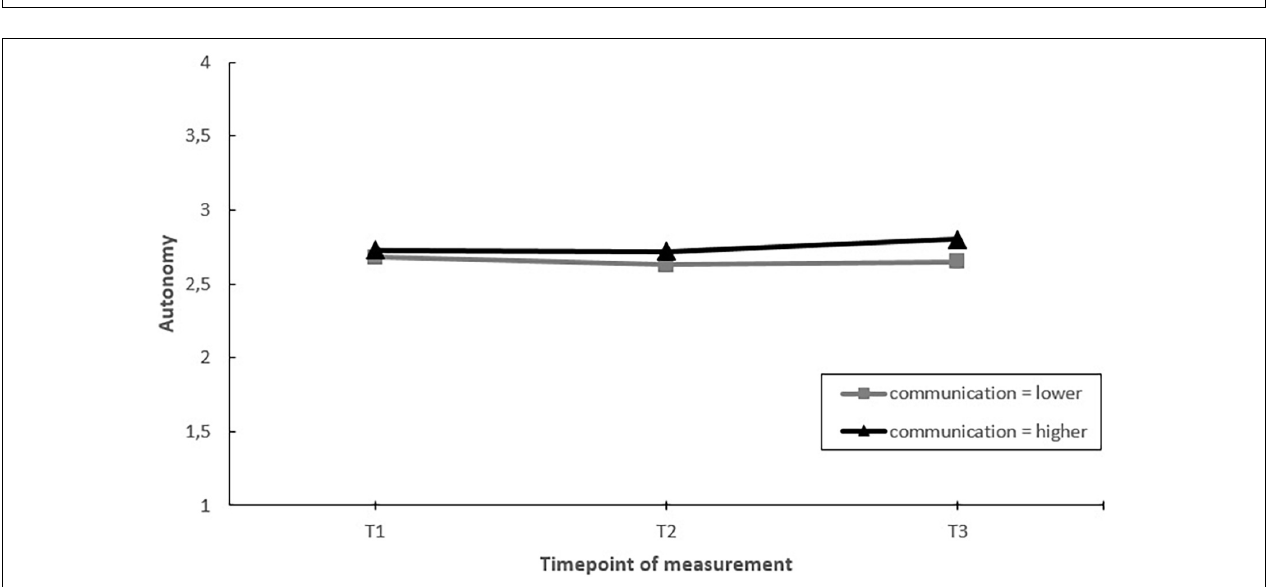
FIGURE 7 | Moderation effect of emergency departments with higher levels of communication versus emergency departments with lower levels of communication during the intervention project on changes in autonomy over time. T1 = 2017, T2 = 2018, T3 =